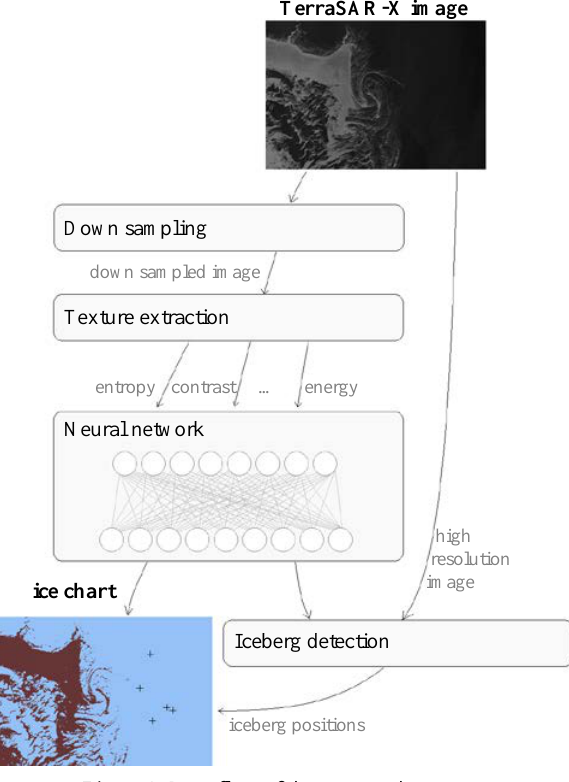
Figure 1. Data flow of the proposed